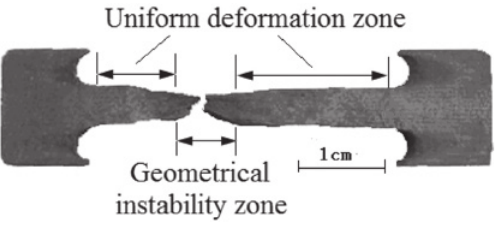
Fig. 4: Photo of tensile failure